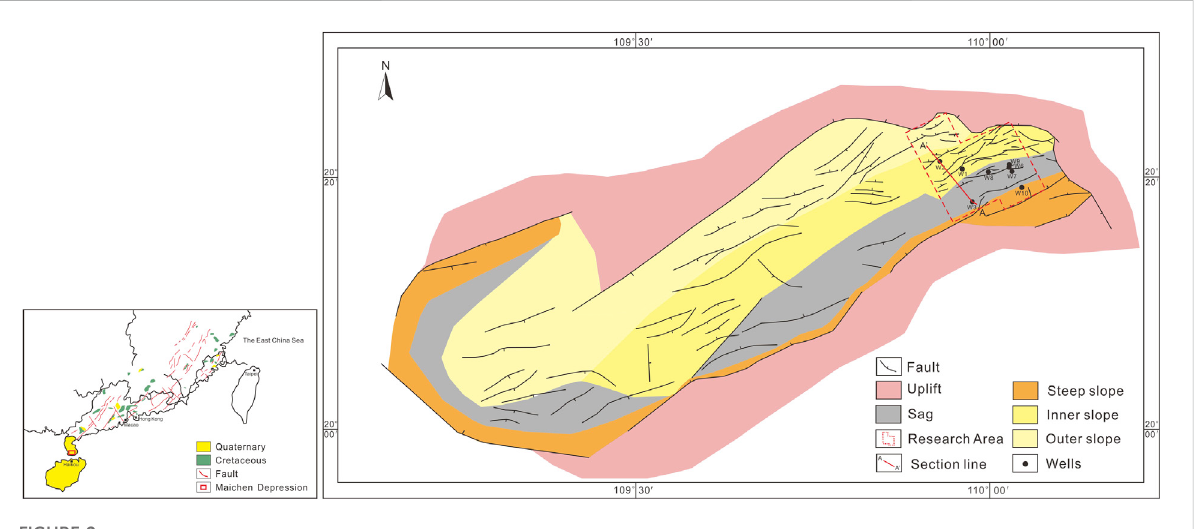
FIGURE 2 Location of the research area.